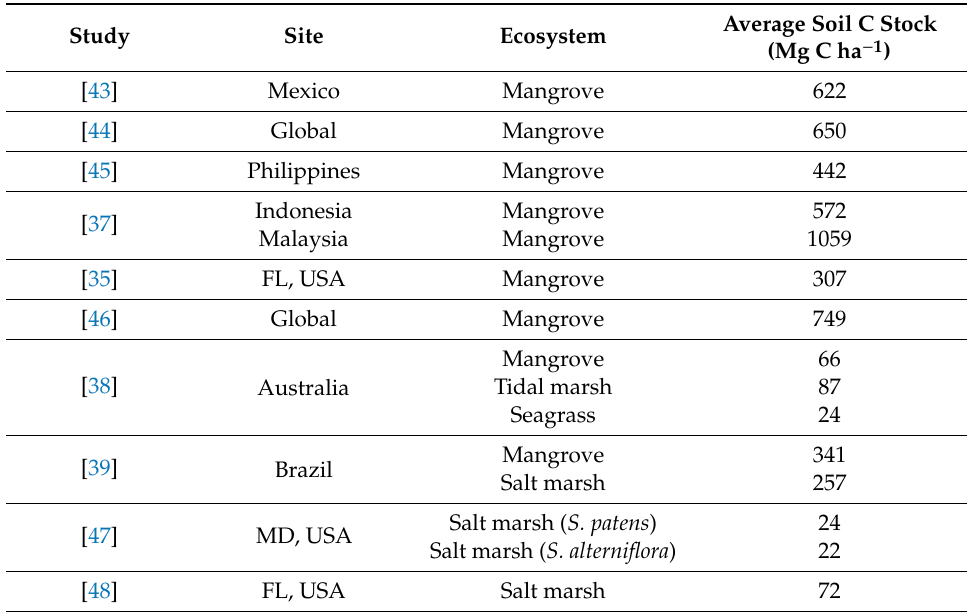
Table 1. Comparison of the soil C stocks in di ff erent types of